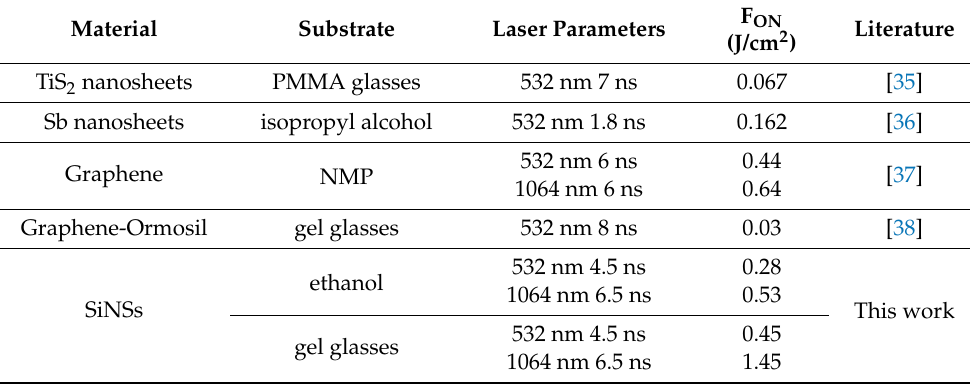
Table 4. Comparison of the F ON of different